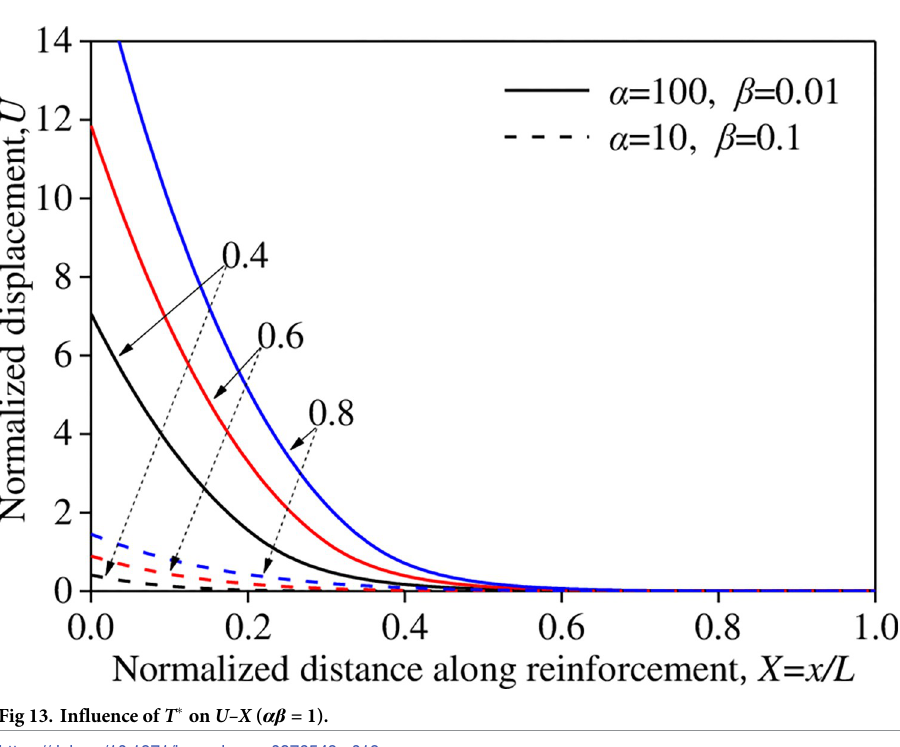
Fig 13. Influence of T � on U–X ( αβ = 1).